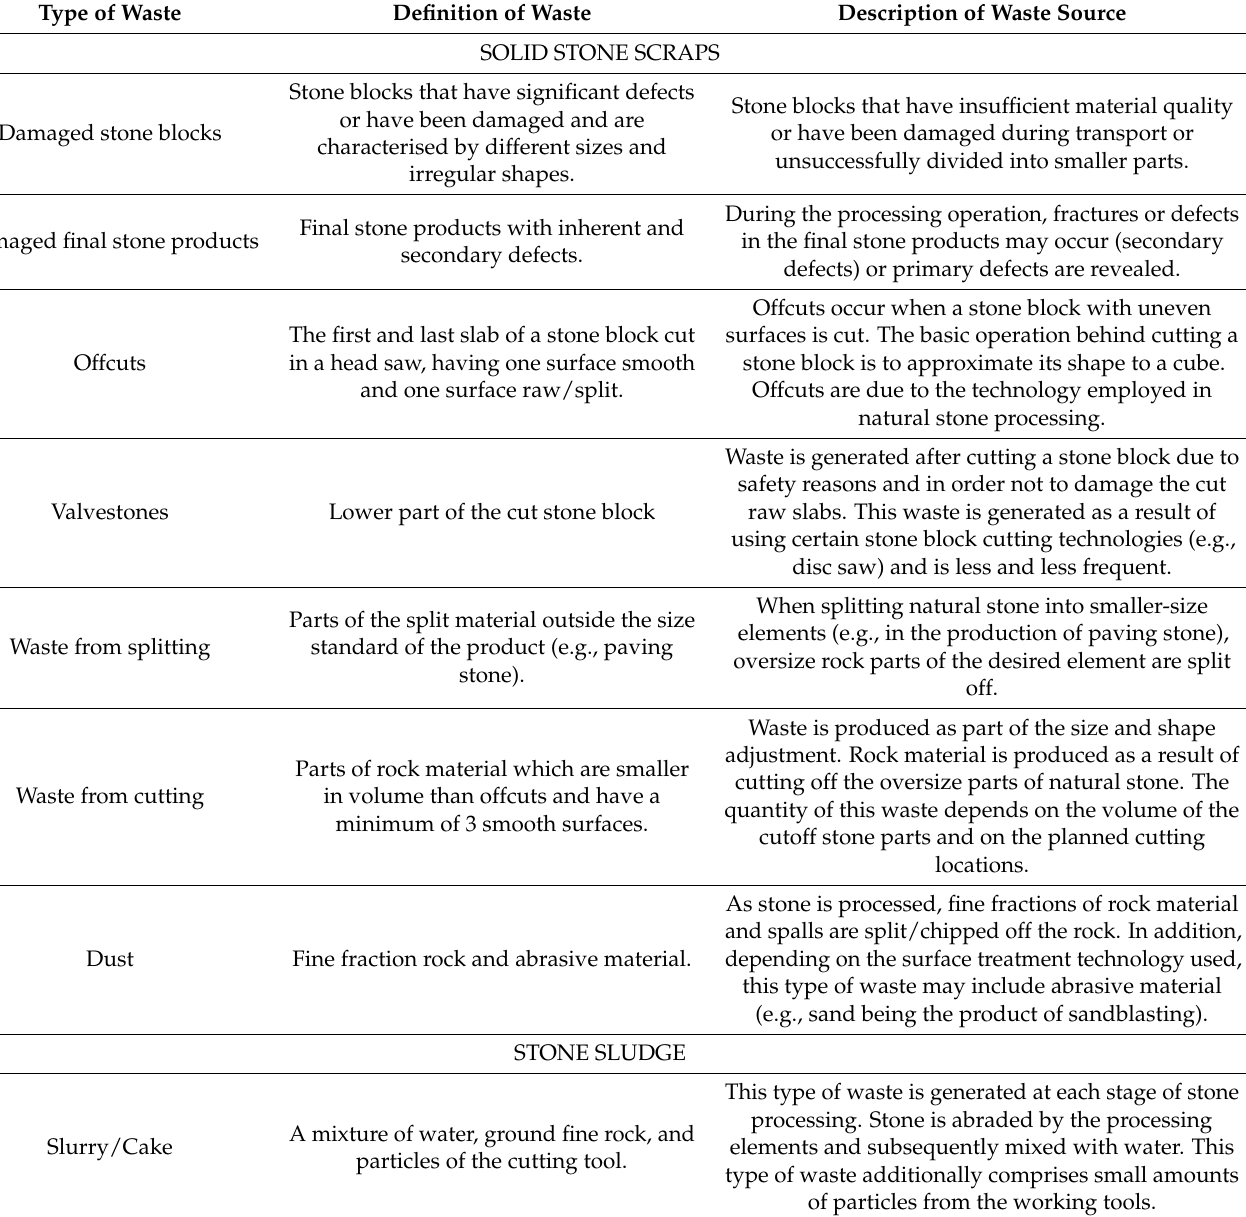
Table 1. Characteristics of waste from the processing of natural